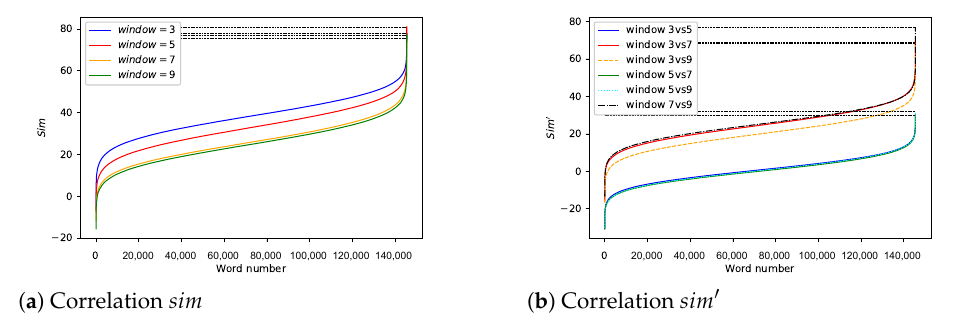
Figure 14. Correlation trend as window